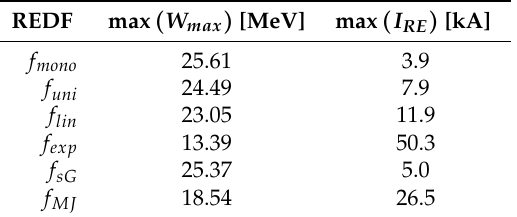
Table 2. The maxima of W max and I RE over the time domain of the whole discharge, plotted in Figure 2.